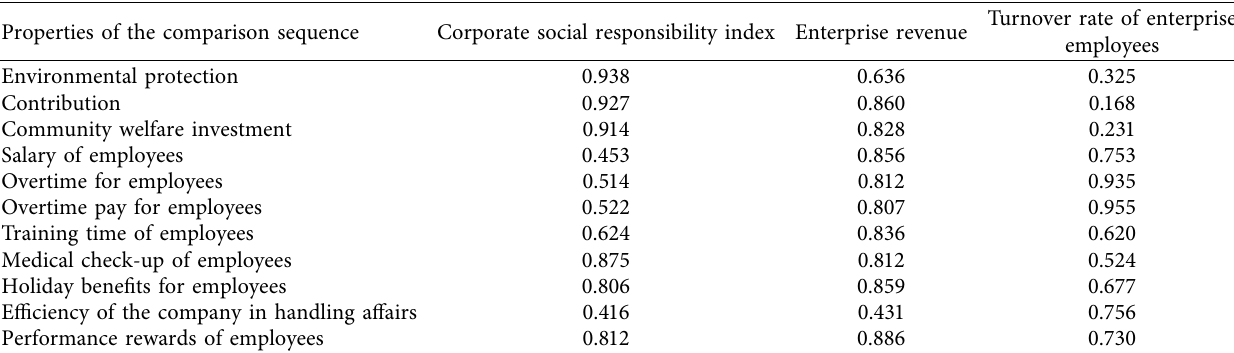
Figure 5: Experimental simulation analysis results of two mainstream data analysis strategies and grey management degree. Table 1: Correlation between corporate social responsibility index, corporate revenue, and employee turnover rate and each comparative attribute.